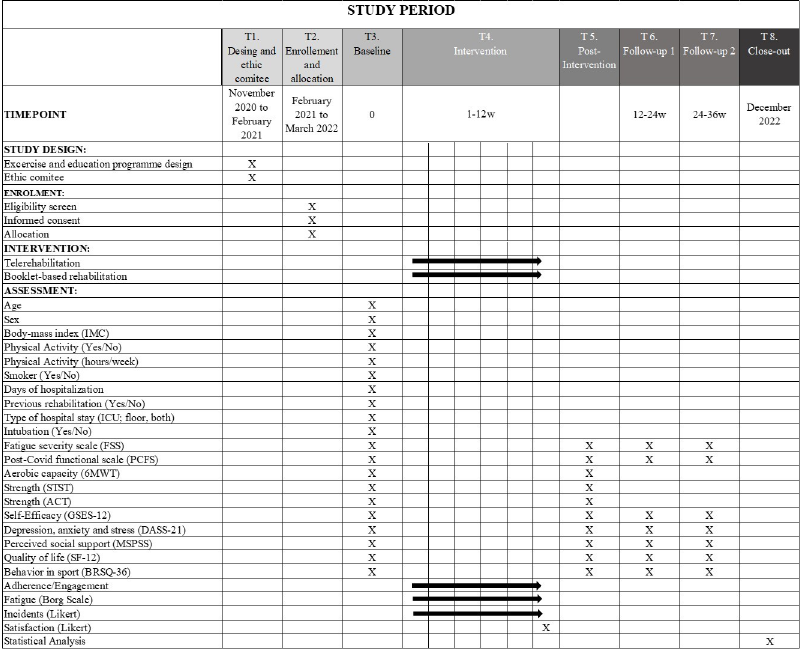
Fig 1. SPIRIT statement. Description of the study steps: 6MWT: 6 Meter Walk Test; STST: Sit-To-Stand Test; ACT: Arm Curl Test; GSES-12: General Self Efficacy Scale; DASS-21: Depression, Anxiety and Stress Scale; MSPSS: Multidimensional Scale of Perceived Social Support; SF-12: Self-reported Quality of Life Questionnaire-version 2; BRSQ-36: Behavioral Regulation in Sport Questionnaire.